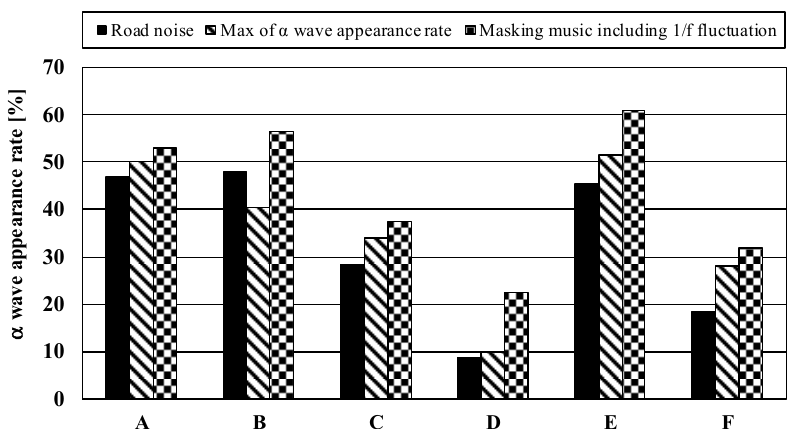
Figure 7. Experiment result of the rate of participants for each music.